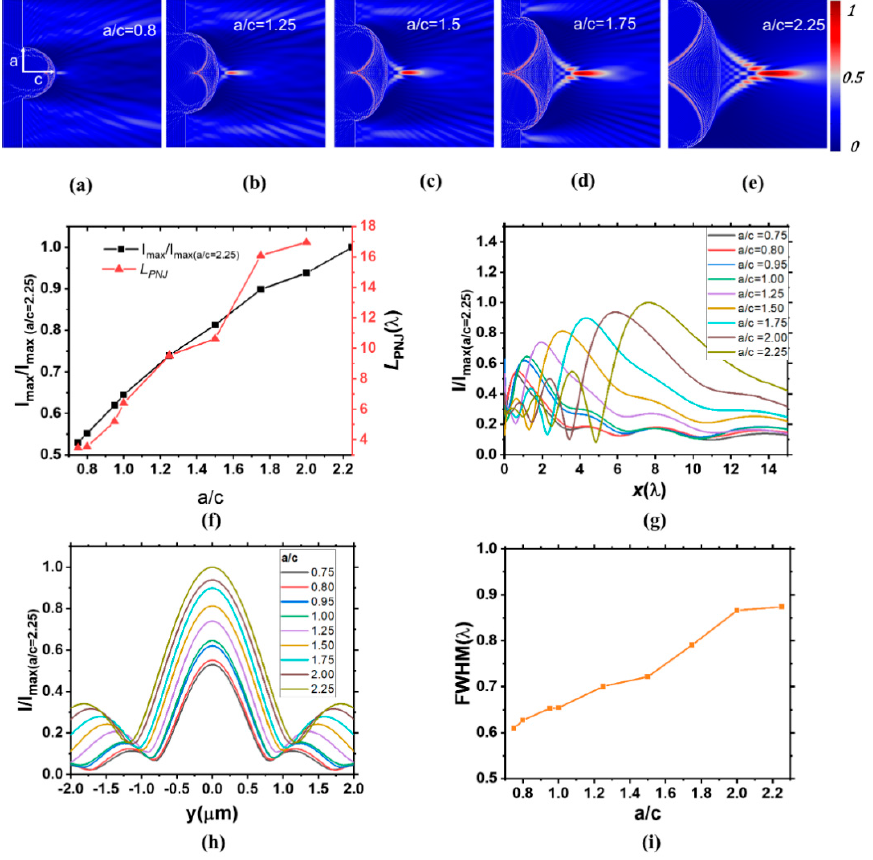
Figure 4. Electric field intensity of PNJ with varying equatorial radius of the dome ( a − e ). Maximum electric field intensity ( I max ) normalized to I max of a / c = 2.25 and L PNJ are shown in ( f ). Normalized electric field intensity along the length of PNJ from the pole of the dome is shown in ( g ). All curves are normalized to the 𝐼 (cid:3040)(cid:3028)(cid:3051) of 𝑎/𝑐 = 2.25 . Relative field intensity across the PNJ waist is shown in ( h ). The FWHM of PNJ beam waist as function of ratio of equatorial and polar radius is shown in ( i ).